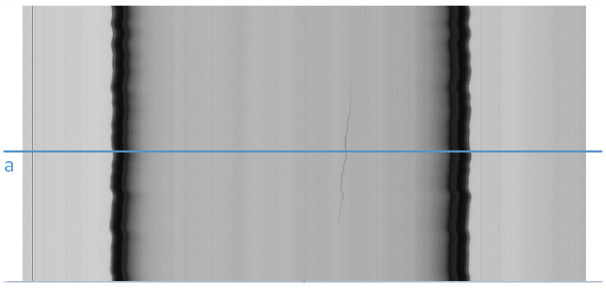
Figure 8. A frame with an air line defect. Row a is a row including the air line.